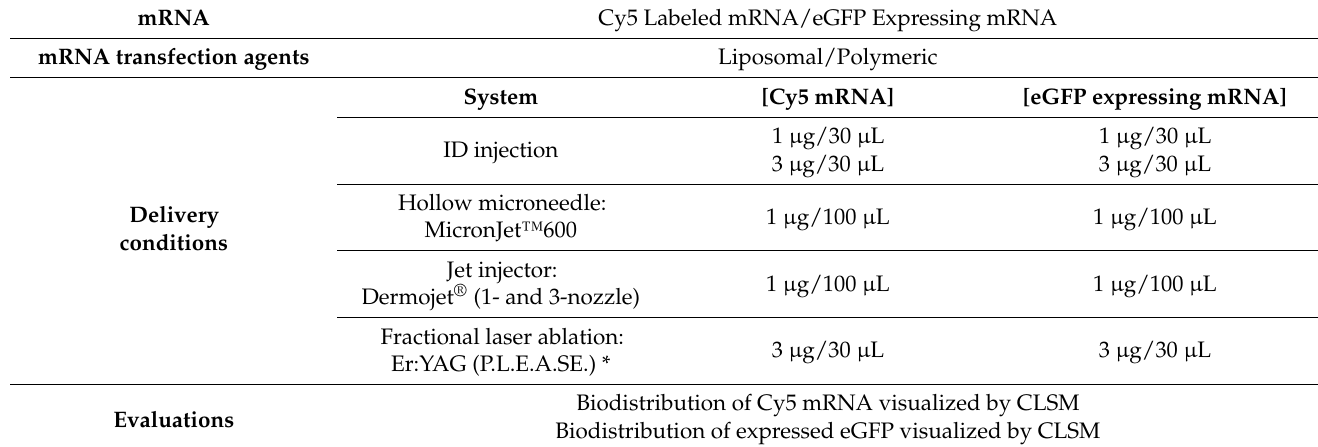
Table 1. Summary of various delivery systems, mRNA formulations, and post-delivery